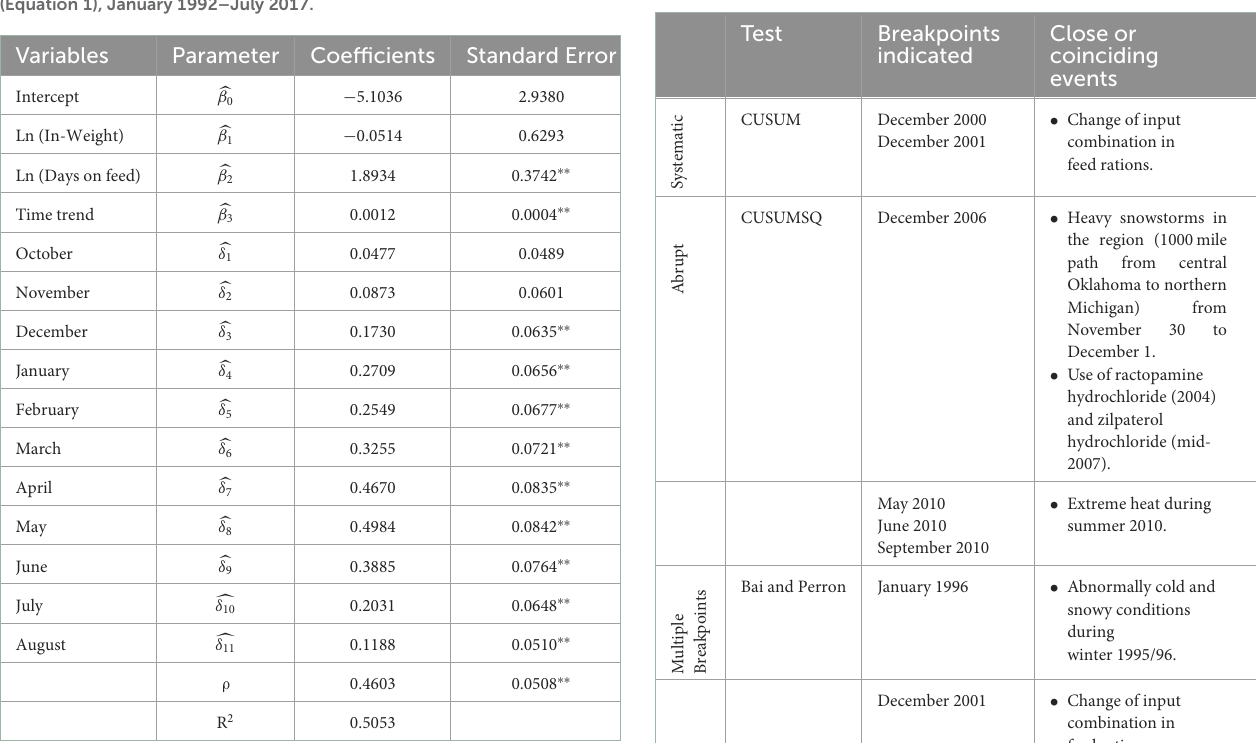
TABLE 4 Structural change test results and coinciding events.